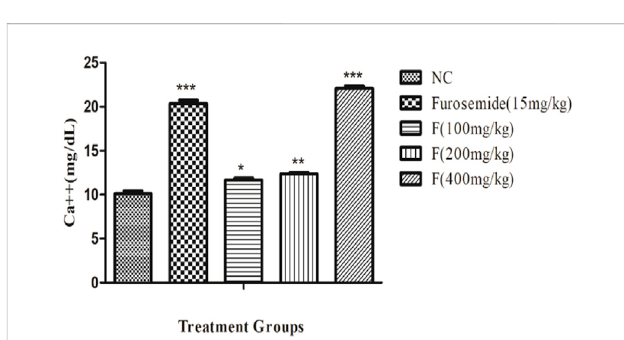
FIGURE 5 Effect of different doses of fenchone on urinary calcium where furosemide was taken as the standard drug. Data are stated as mean ± SEM, N = 6. *** p < .001 represents a signi fi cant increase, while ’’’ p < .001 represents a signi fi cant decrease vs. normal